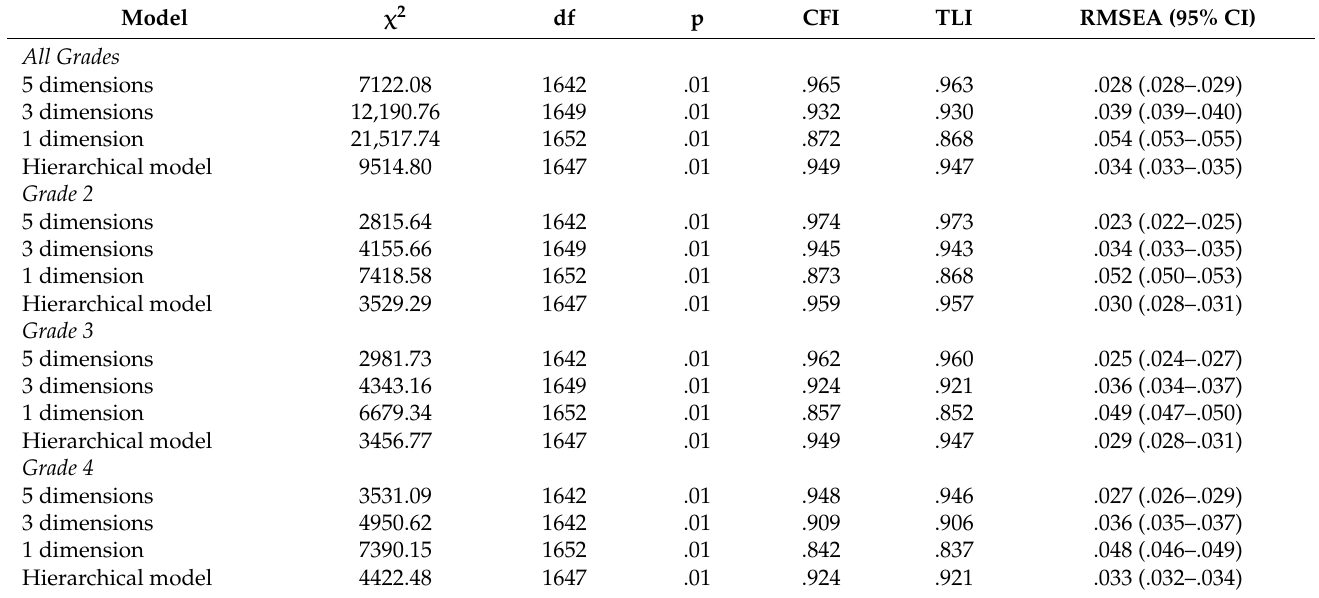
Table 4. Goodness of fit indexes for testing dimensionality of morphological awareness.